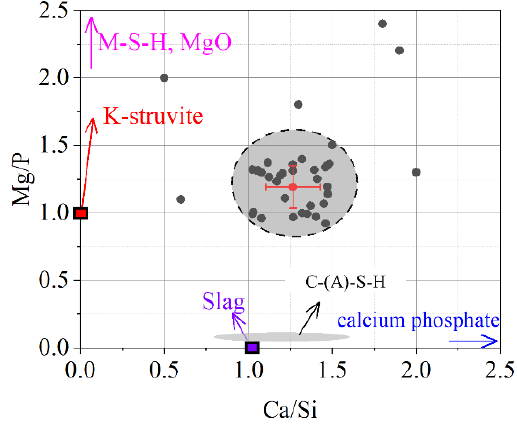
Figure 8. Chemical composition of the reaction product.